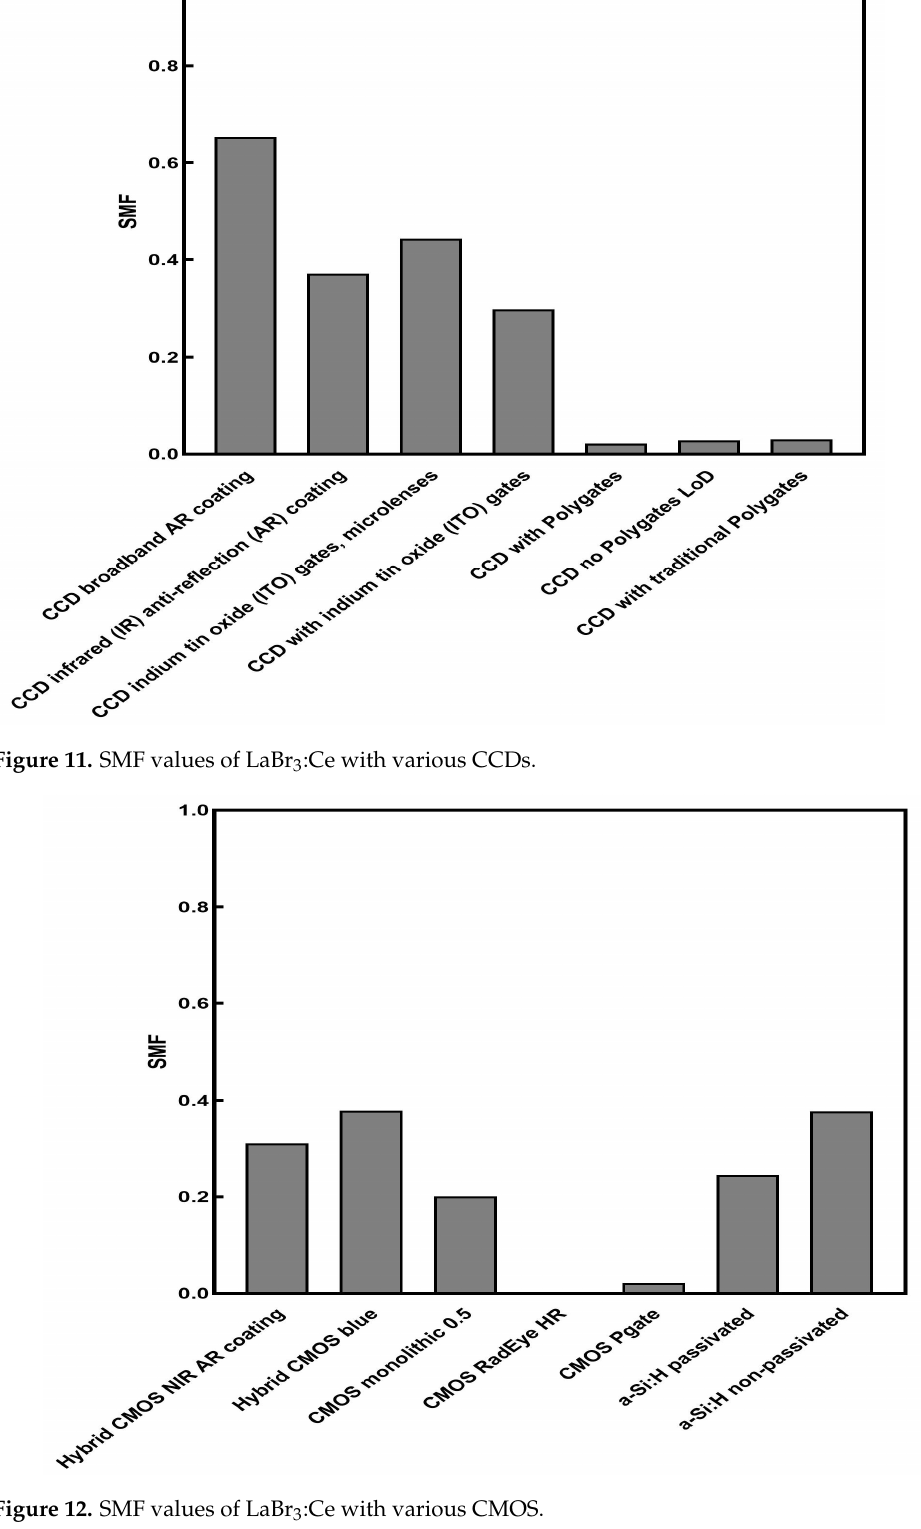
Figure 13. SMF values of LaBr 3 :Ce with various photocathodes.